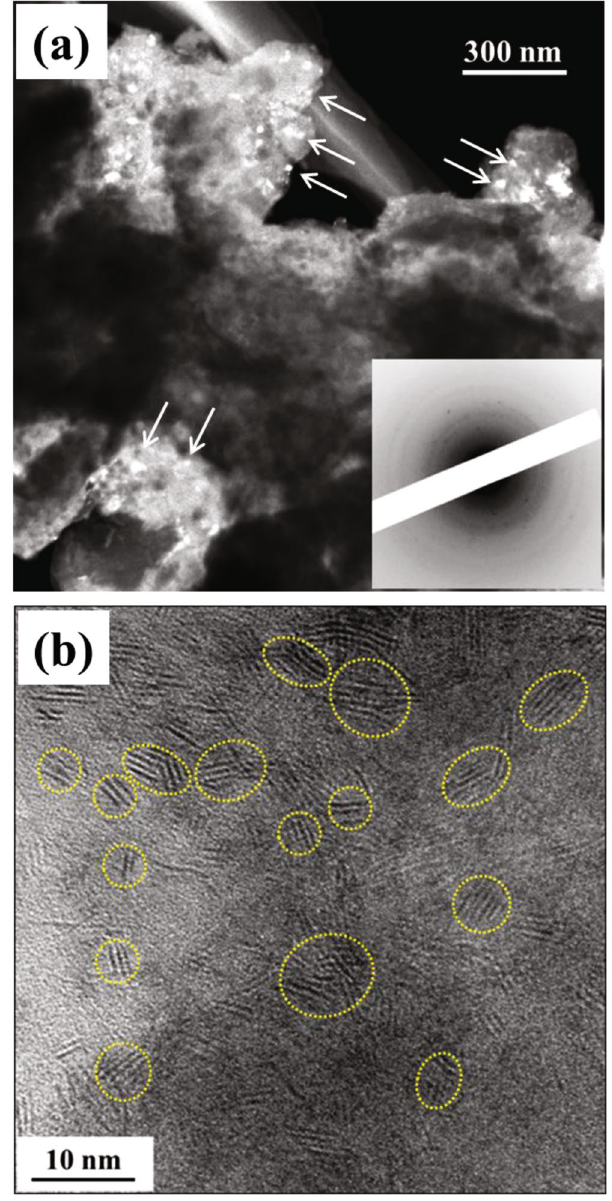
Figure 3. The DF image ( a ) and HR-TEM image ( b ) indicating the microstructure of the 75Li 2 S·25P 2 S 5 glasses, together with the corresponding ED pattern in the